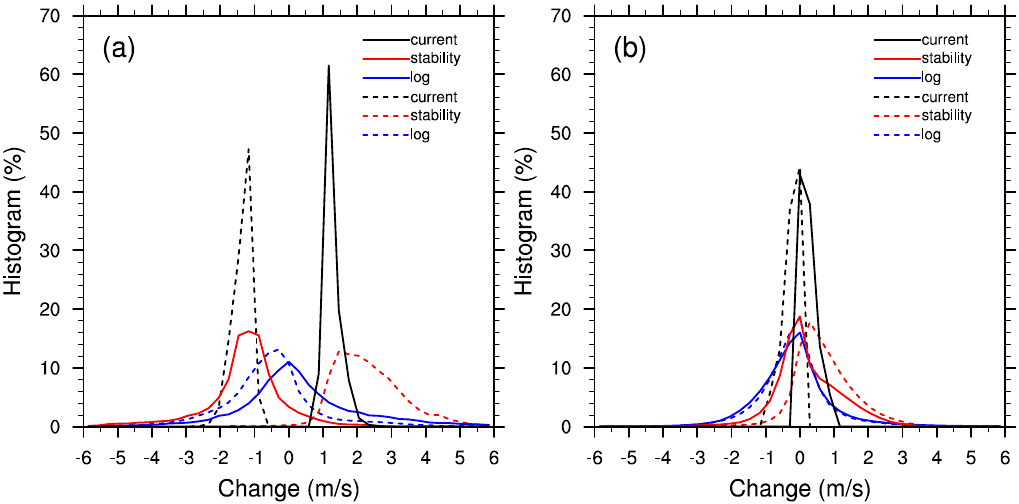
Figure 7. Histogram of six hourly di ff erences of current, stability and log terms in the log–wind equation between the CUR_WAV and WAV experiments, emphasizing the impact of the currents. The statistics for ( a , b ) are computed over strong-current ( | Us | > 1 m / s) and weak-current ( | Us | < 1 m / s) regions, respectively. Negative currents changes and associated changes in the log profile term and stability term are indicated as dashed lines, and changes associated with positive currents are indicated as solid